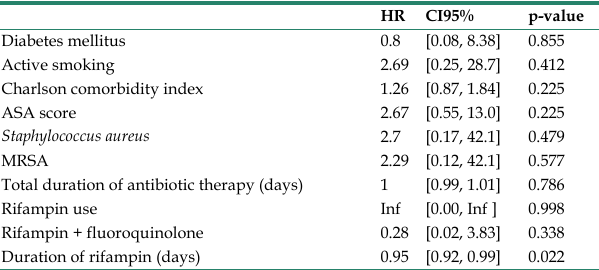
Table 3. Hazard-ratios of treatment failure in multivariate Cox regression